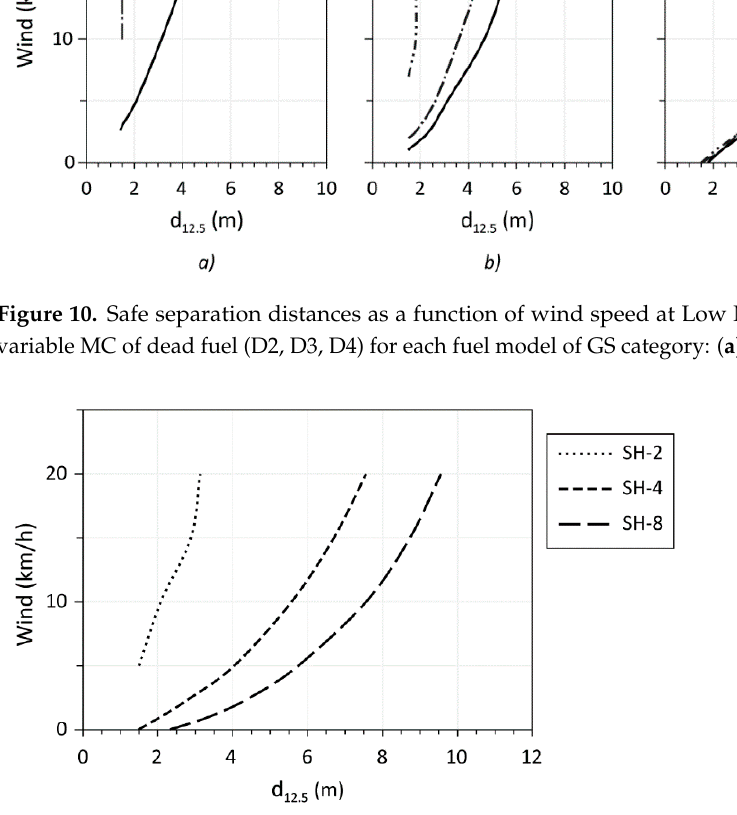
Figure 10. Safe separation distances as a function of wind speed at Low MC of live fuel (L2) and variable MC of dead fuel (D2, D3, D4) for each fuel model of GS category: ( a ) GS-1, ( b ) GS-2, ( c ) GS- 3.